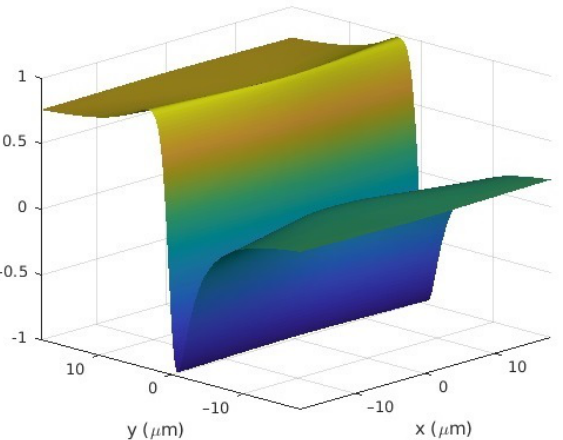
Figure 7. The spatial variation of the optical ellipticity, as defined by (72) for pump ellipticities of P ( 1 ) = 0 and P ( 2 ) = 1 with a total normalised pump power in each guide of η ( i ) = η Guide ( 2 ) is to the left in the diagrams (in the positive y